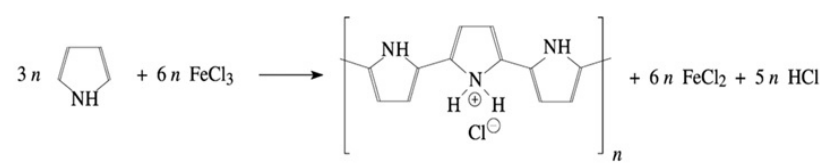
Figure 1. The oxidation of pyrrole with ferric chloride yields polypyrrole. Adapted from Omastová et al. 23 .